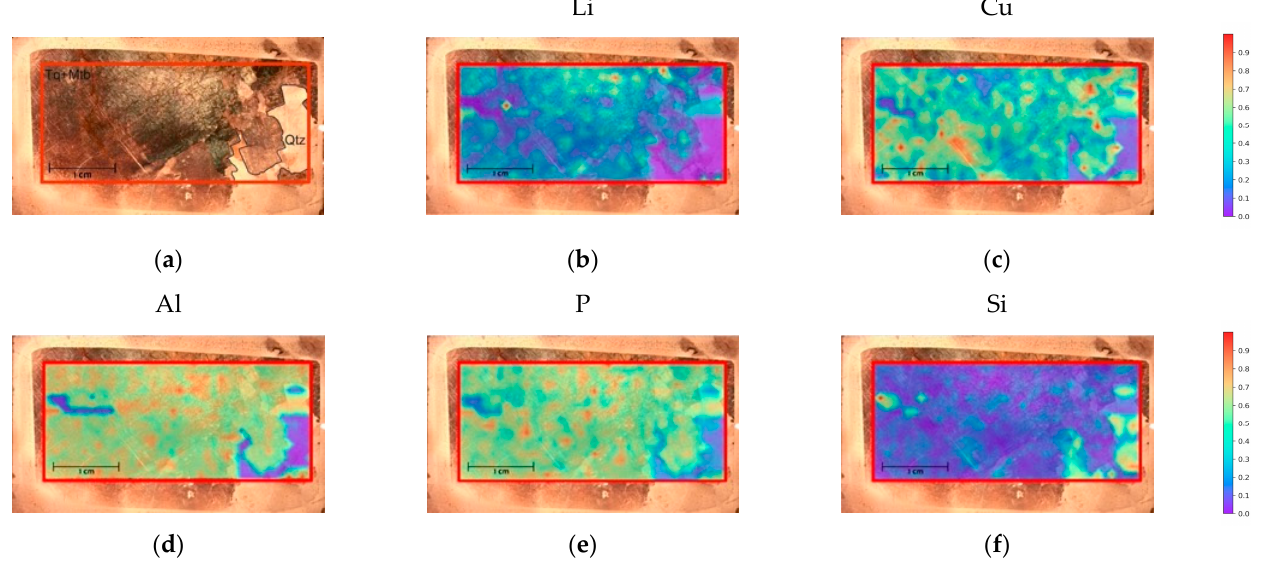
Figure 10. ( a ) Thin section and mineral distribution. ( b ) LIBS mapping overlaid with thin section for Li (812.62 nm). ( c ) LIBS mapping overlaid with thin section for Cu (327.37 nm). ( d ) LIBS mapping overlaid with thin section for Al (369.09 nm). ( e ) LIBS mapping overlaid with thin section for P (213.51 nm). ( f ) LIBS mapping overlaid with thin section for Si (288.13 nm). Note: For ( b – f ), the color scale represents normalized intensity counts.